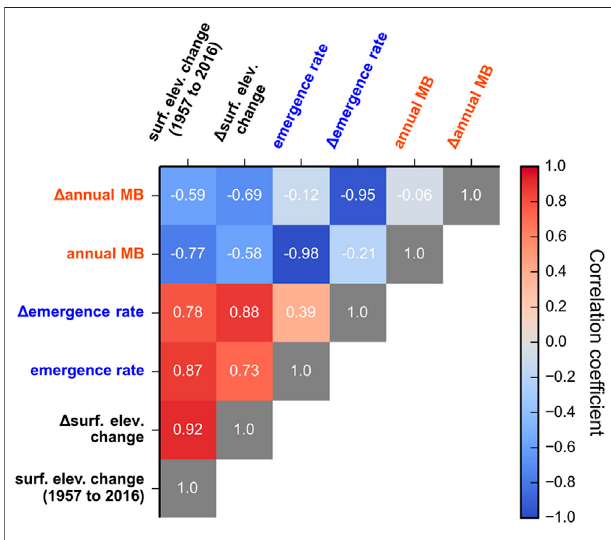
FIGURE 8 | Correlations between ice continuity terms as they change over multiple decades. Correlations between all terms in the continuity equation can be read from the matrix. As an example: A high positive correlation(red)betweensurfaceelevationchangeand Δ emergencerate indicates that the negative surface elevation change from 1991 to 2015 is positively correlated with the negative decline in ice emergence rate in time. See Figure 3 for the patterns and signs of each term in this fi